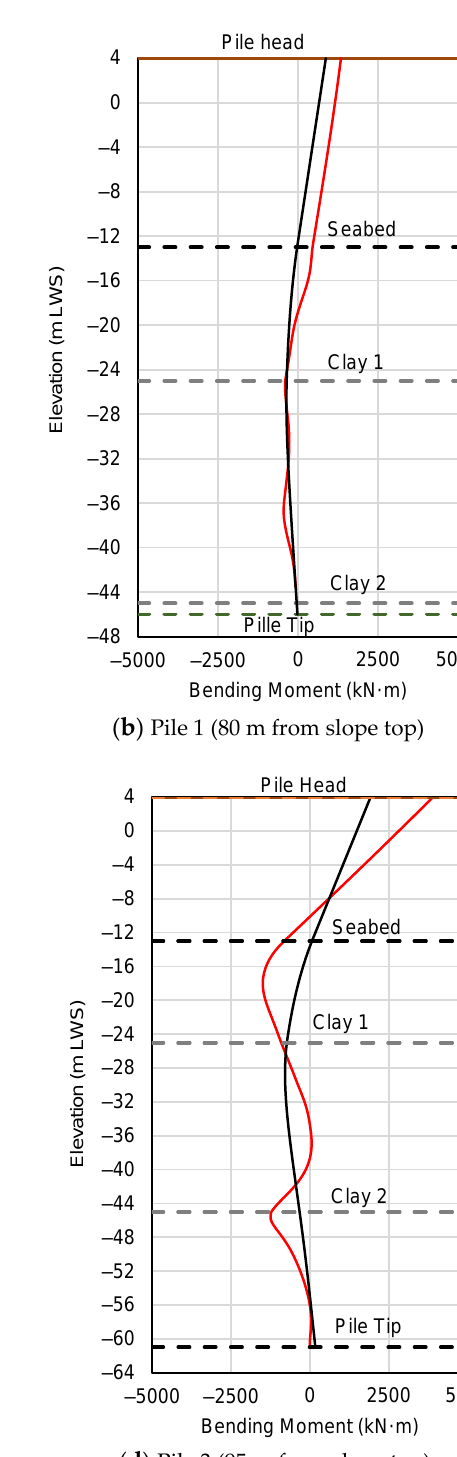
Figure 18. Bending moment distribution of the PSW considering the inertial forces due to the TE waveform (Scenario 2).